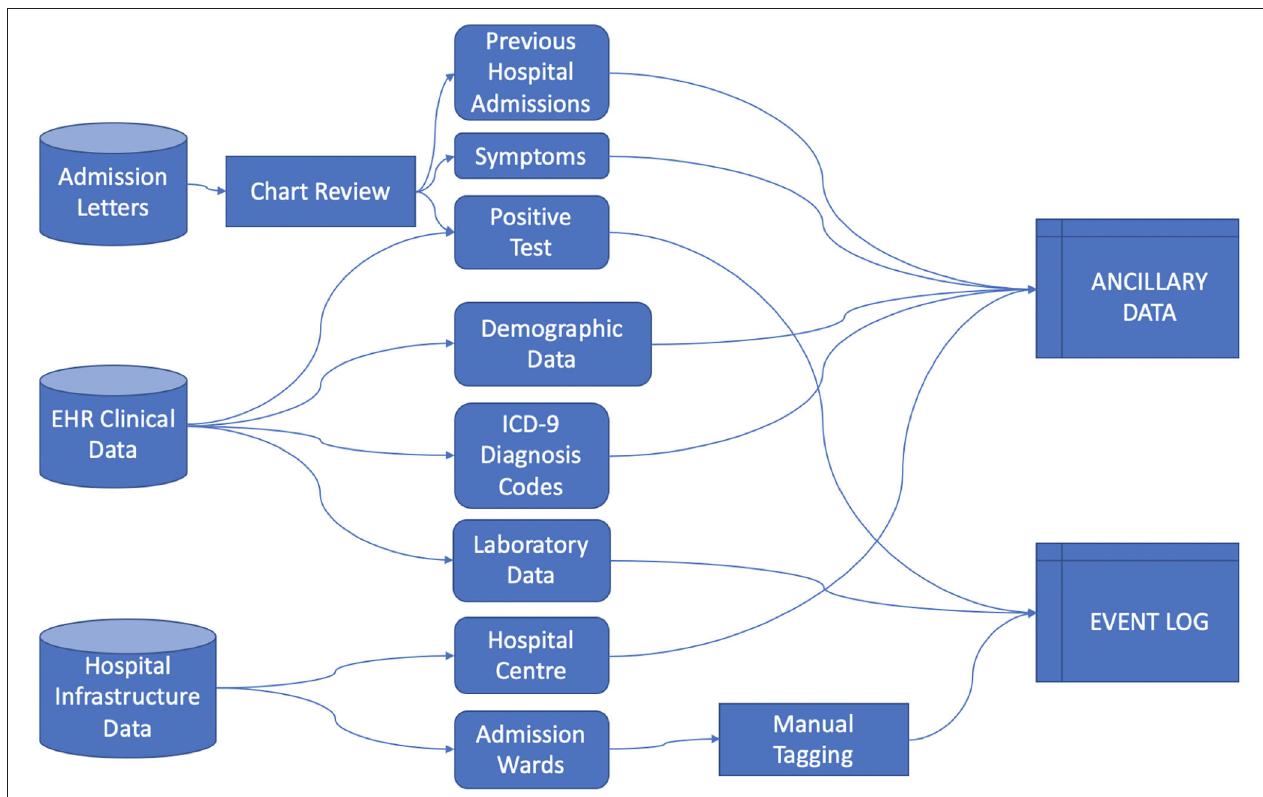
FIGURE 1 | Data acquisition